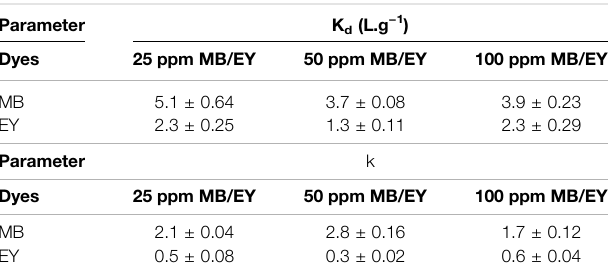
TABLE 4 | Distribution (K d ) and selectivity (k) coef fi cients of HCl-treated p (APTMACl-co-AMPS)-3 hydrogels for the adsorption of MB and EY from their mix solutions at different